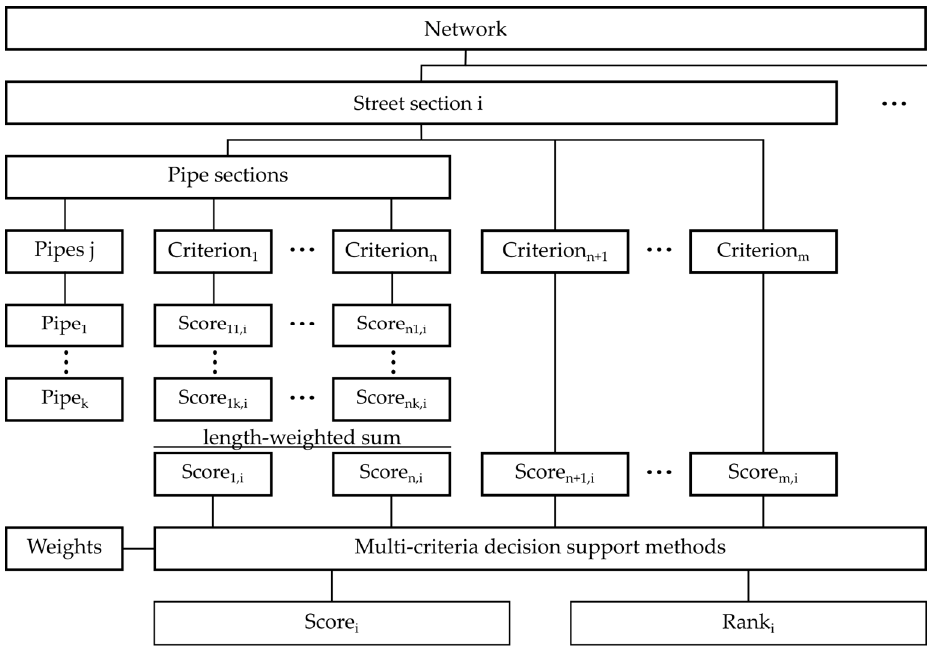
Figure 1. Flowchart of the score and rank estimation for the individual networks.